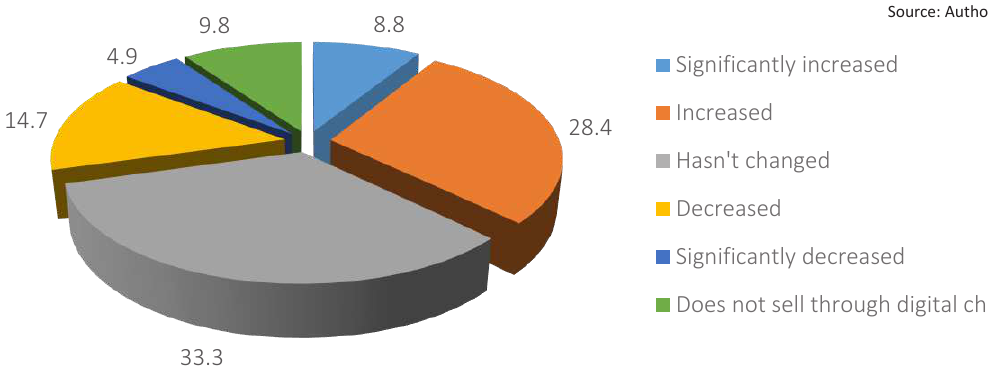
Figure 3. Changes in the SME sales volume of products/services through digital channels since the start of the pandemic (%)